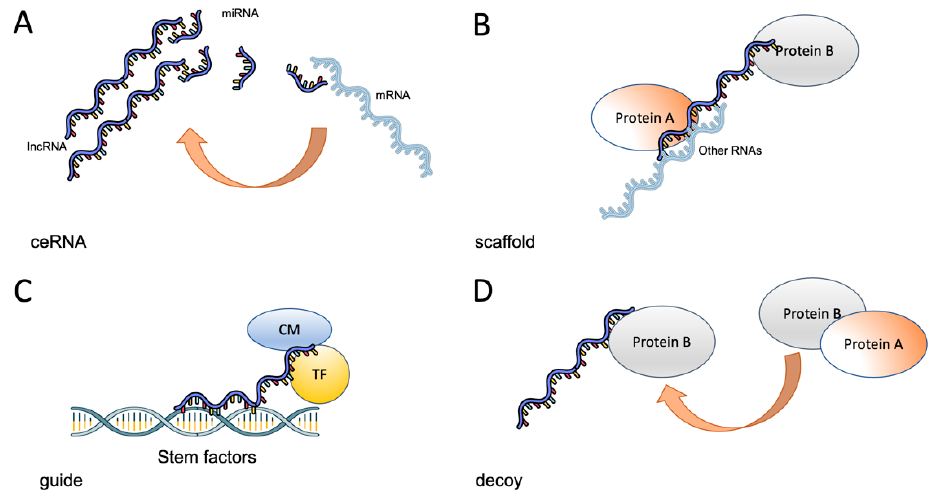
Figure 1. LncRNAs can be classified according to their function as: ( A ) sponges that act as competing endogenous molecules (ceRNAs) that interact with microRNAs and thus prevent them from interacting with their cognate mRNAs; ( B ) scaffold lncRNAs that act as adaptors to proteins; ( C ) enhancer or guide lncRNAs that stabilize chromosomal loops or recruit chromatin modifiers to DNA and ( D ) decoy lncRNAs, which act by sequestering